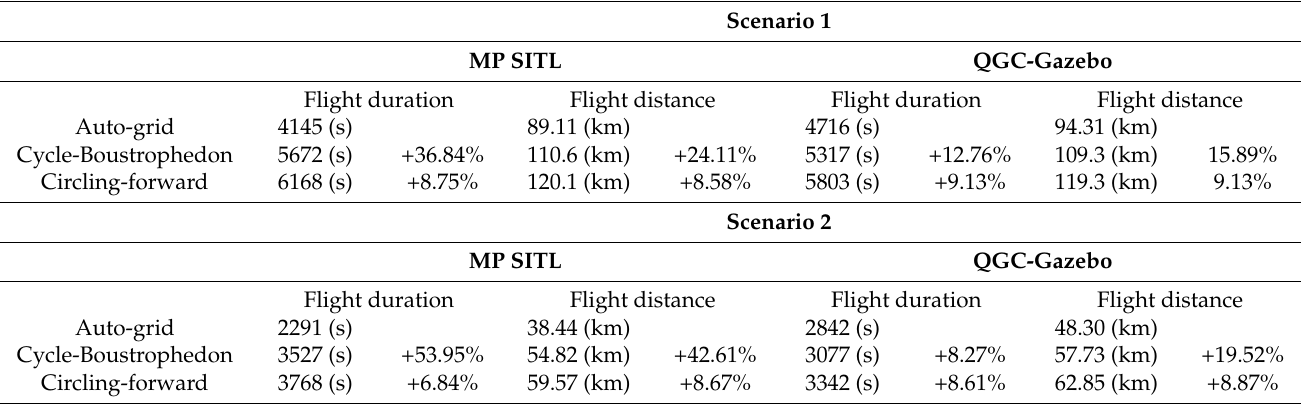
Figure 21. The 2D trajectory results of scenario 1 in blue lines, the not approached sampling points in red circles, and the turning route between first two parallel tracks in bold lines of ( a ) cycle- Boustrophedon ( b ) circling-forward in simulation platform 1. Table 5. Comparison of the flight duration and distance between different methods on different